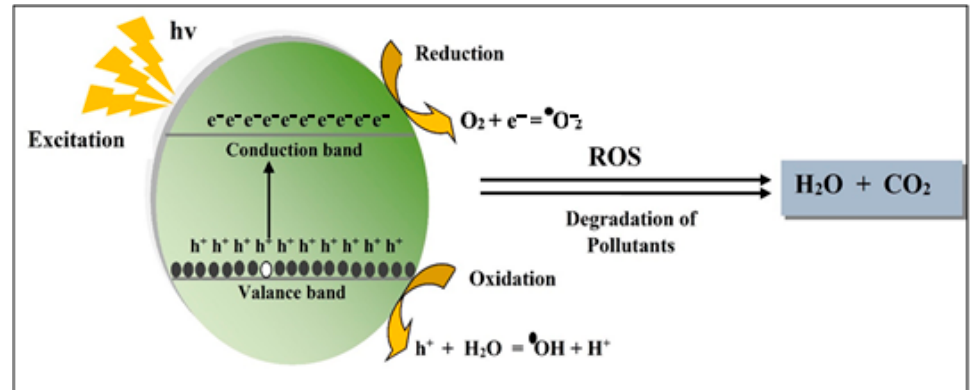
Figure 6. TiO 2 NPs driven photocatalytic process in the presence of light.